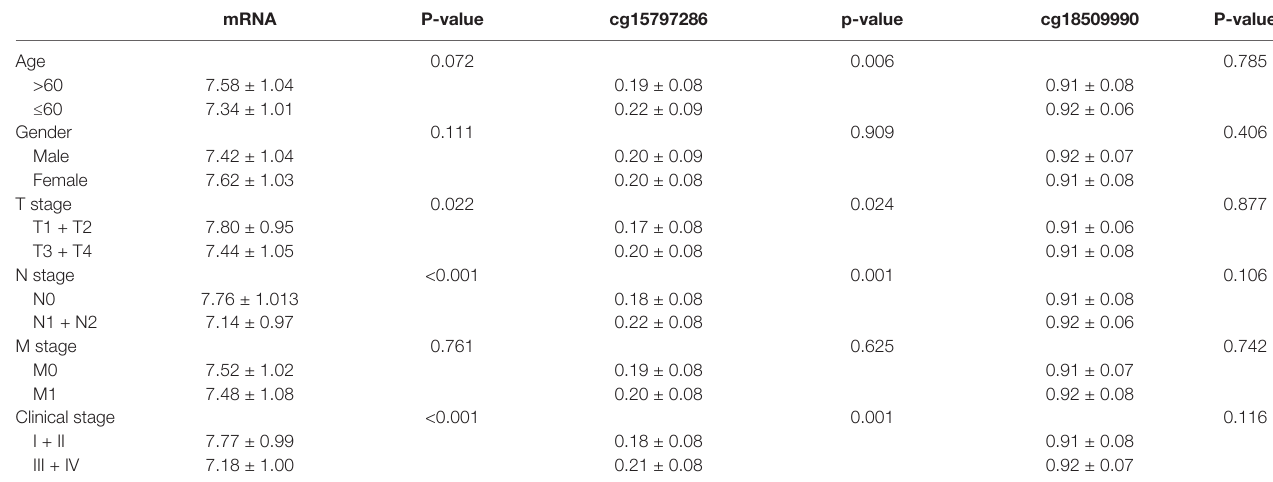
TABle 4 | Association of N - acetyltransferase 1 ( NAT1 ) mRNA and two CpG sites with clinicopathological features of colon adenocarcinoma (COAD).